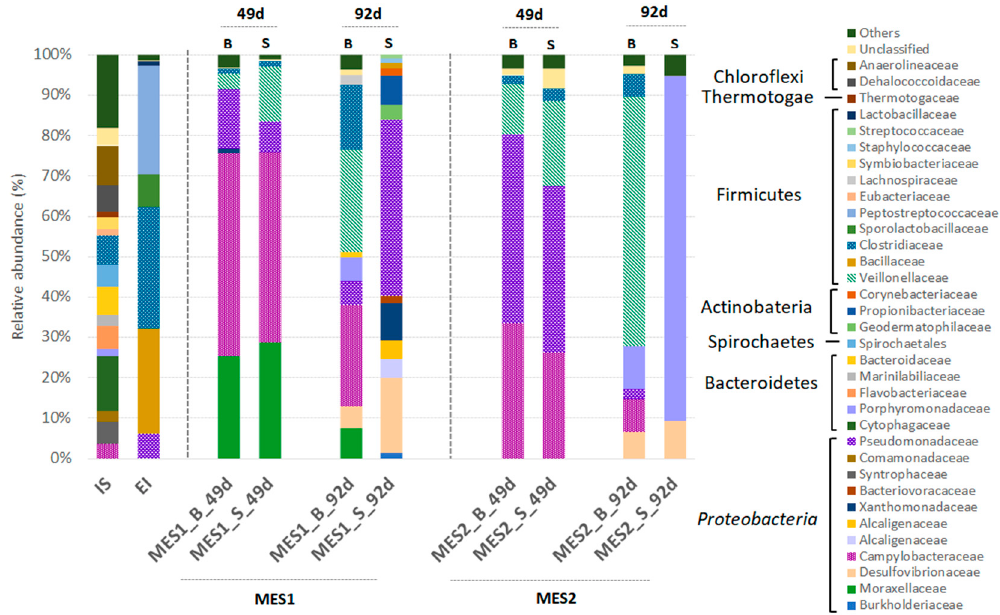
Figure 5. Taxonomic classification of eubacterial communities at family levels and the phyla to which these families belong.